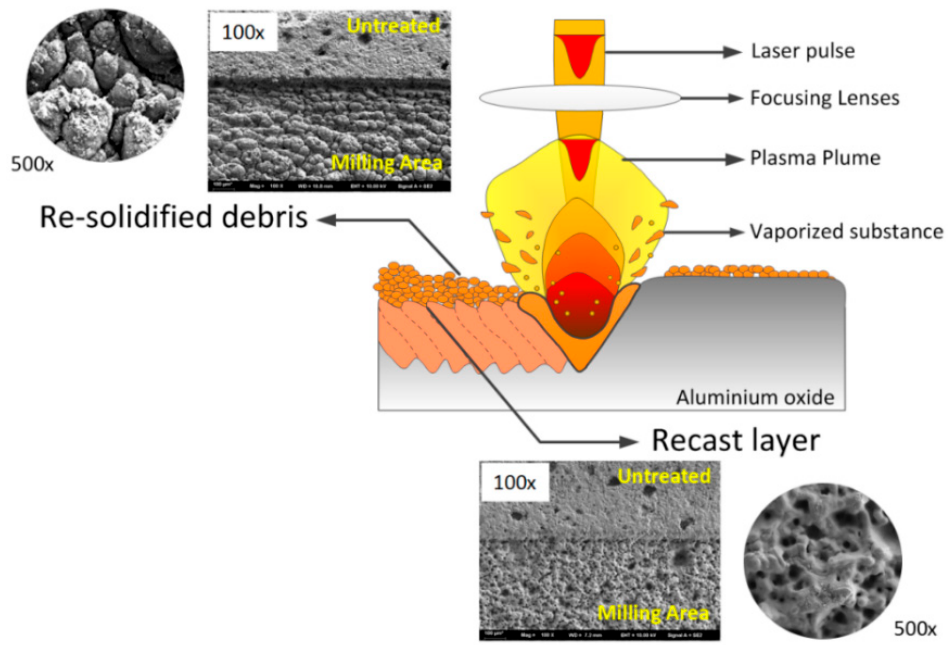
Figure 12. Formation mechanism of surface microstructure of Al 2 O 3 ceramics after laser milling.